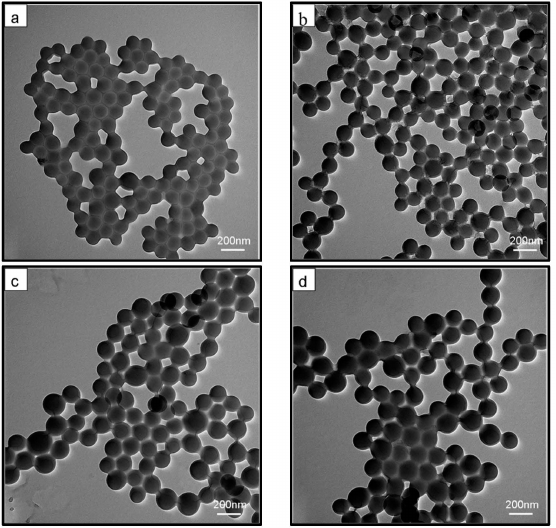
Figure 1. TEM micrographs of the final particles prepared by emulsion polymerization of styrene using methanol solution (20/80 w / w ) as the polymerization medium and various amount of initiator KPS: ( a ) 0.3 wt %; ( b ) 0.6 wt %; ( c ) 0.9 wt %; and ( d ) 1.2 wt